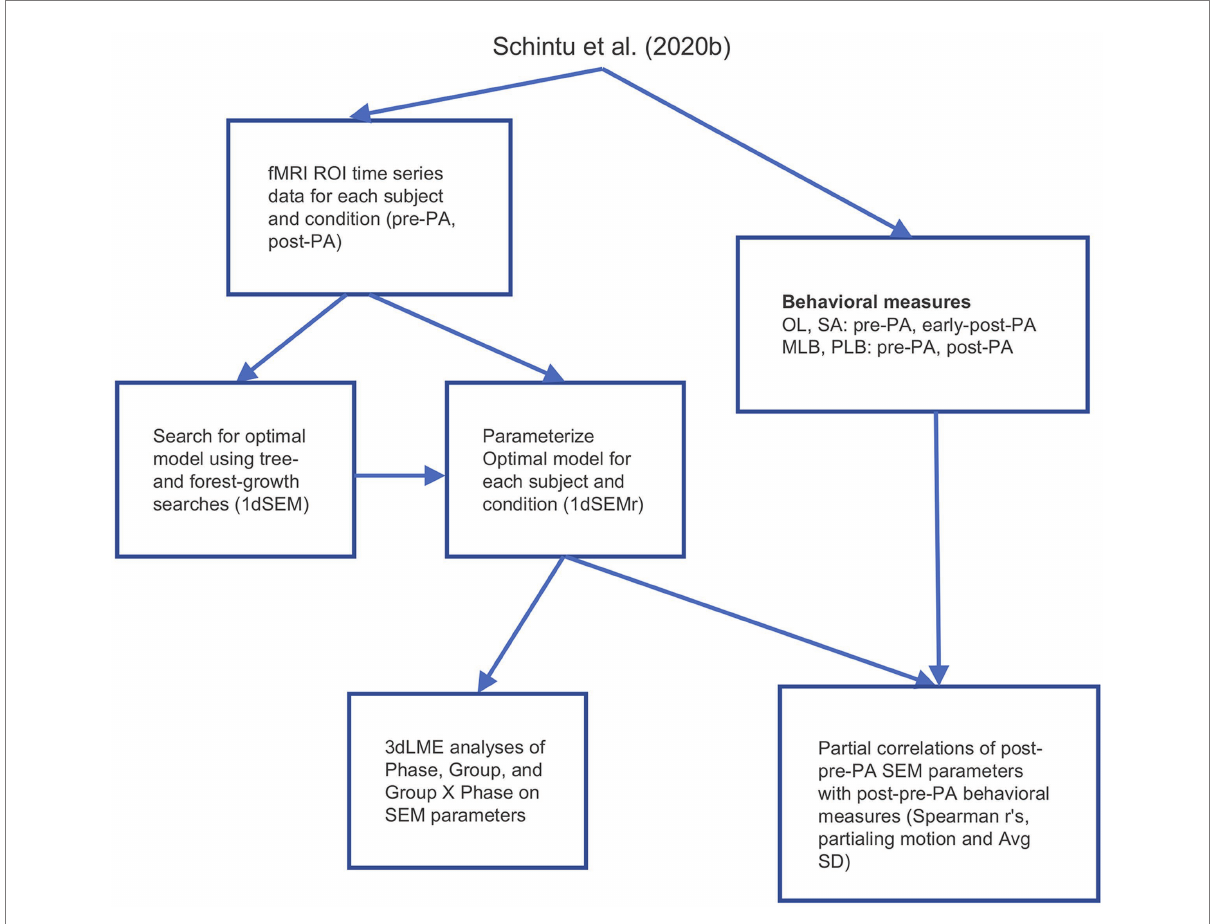
FIGURE 2 Analysis workflow. PLB, perceptual line bisection; MLB, manual line bisection; SA, straight-ahead pointing; OL, open-loop pointing; PA, prism adaptation; SD, standard deviation; SEM, structural equation